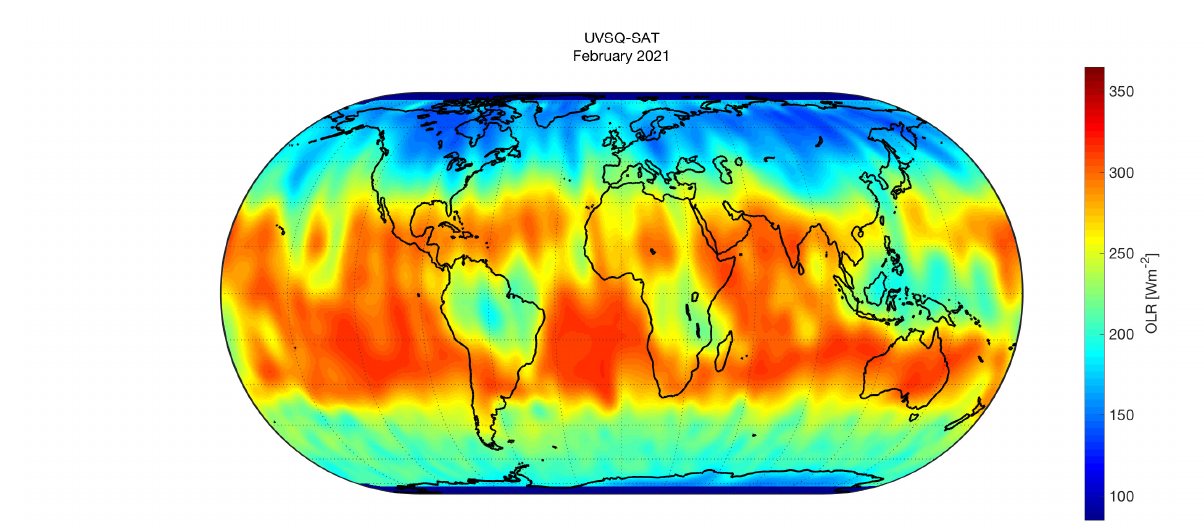
Figure 15. OLR at the TOA measured by UVSQ-SAT